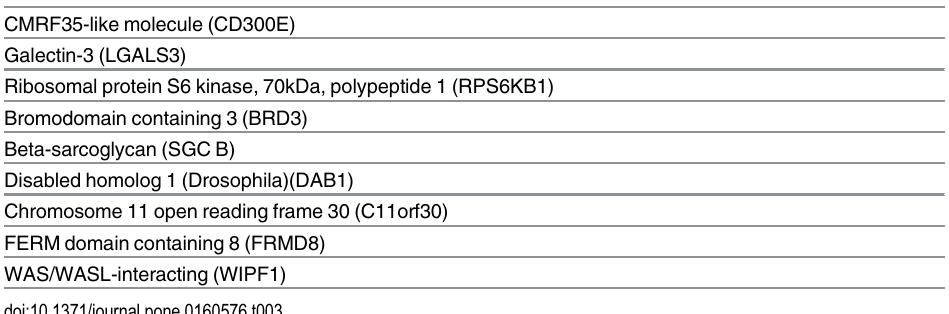
Table 3. 9 candidate antibodies in seromic